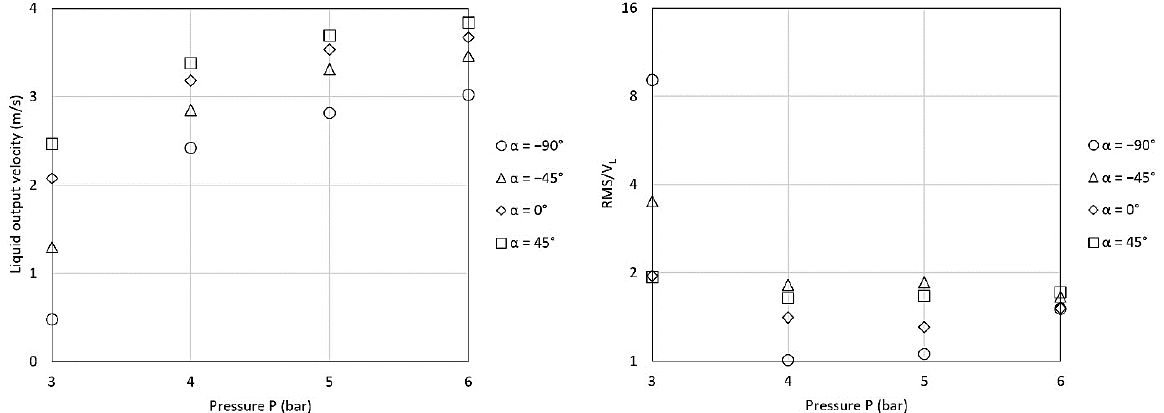
Figure 7. Velocity profiles V in the symmetry axis of the nozzle for the investigated operating parameters.